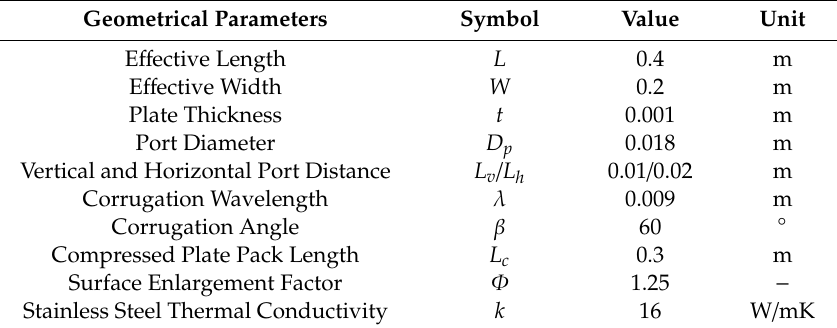
Table 1. Nominal plate geometrical parameters